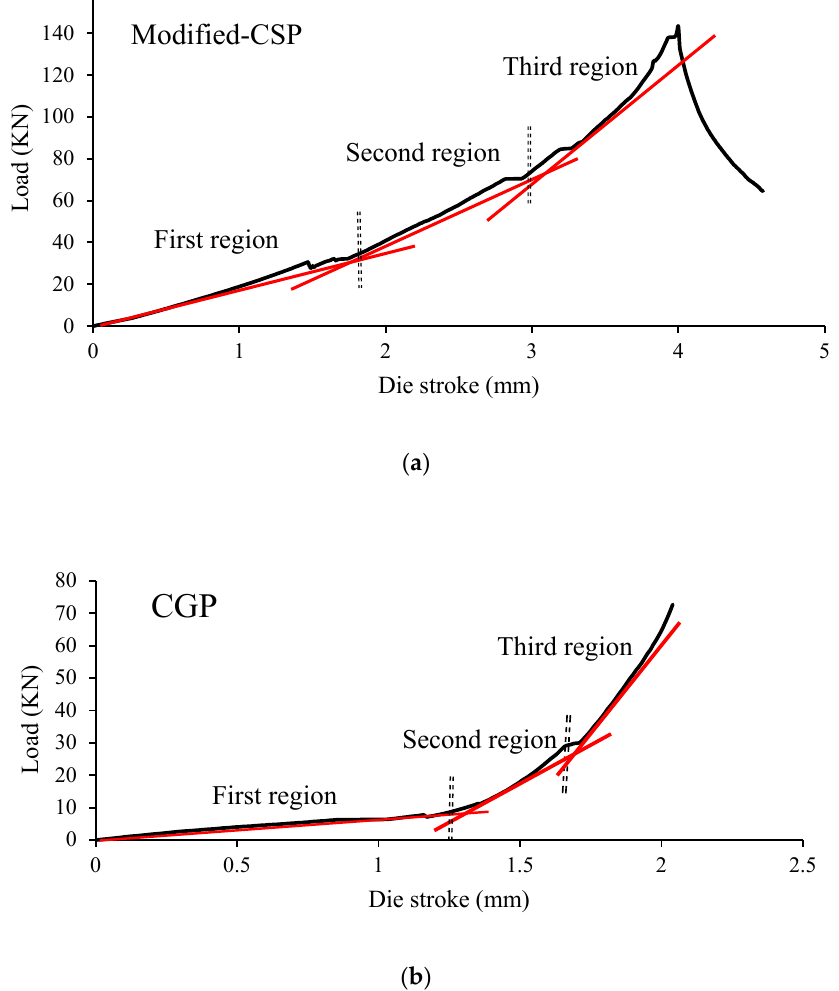
Figure 16. Diagram of load ‐ stroke for ( a ) modified ‐ CSP, and ( b ) CGP during the corrugation step.